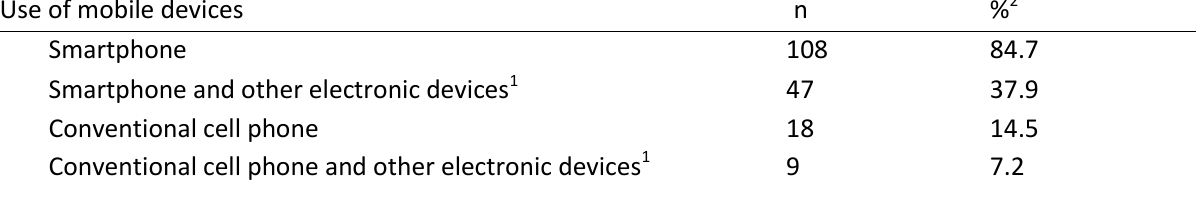
Table 1: Use of mobile devices and operating systems by third year veterinary students (n = 124) Use of mobile devices